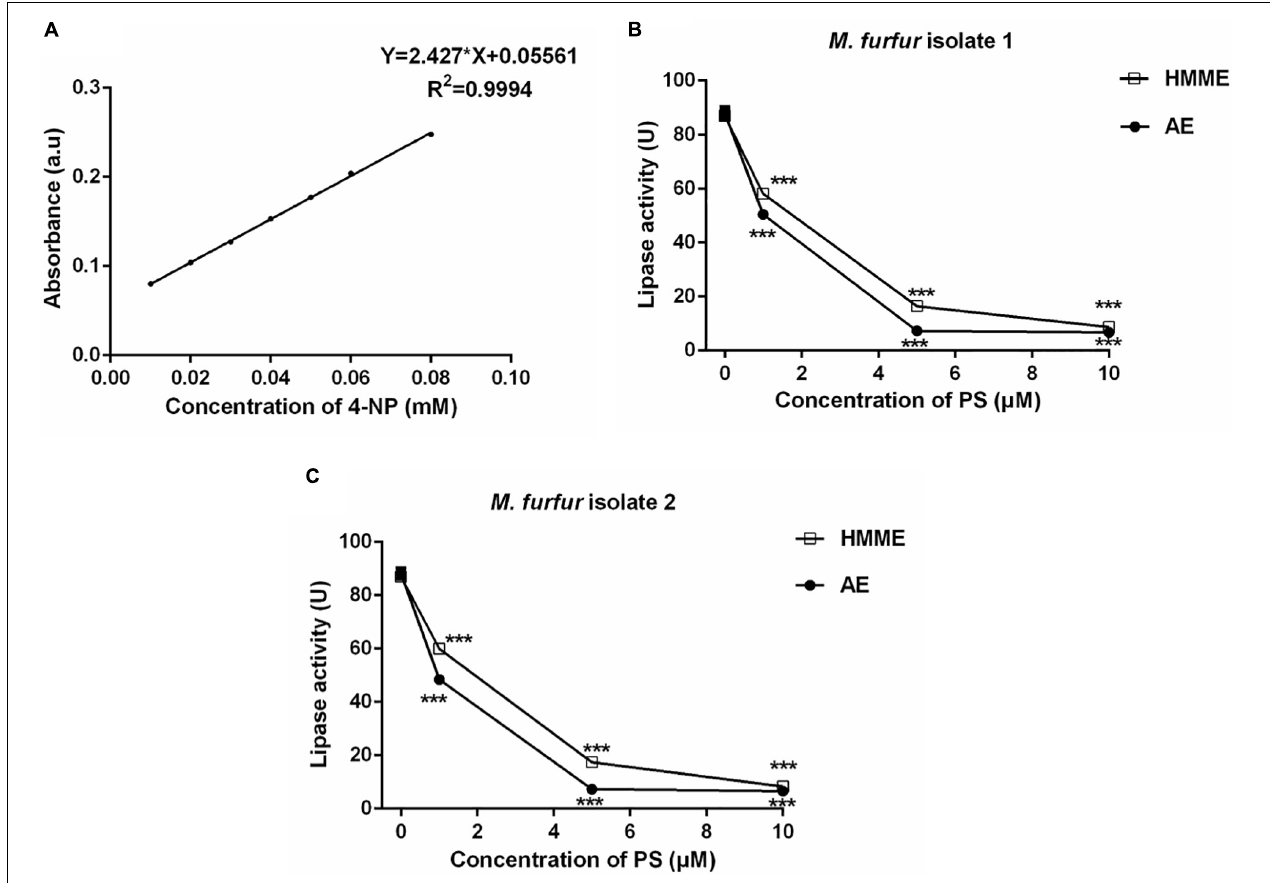
FIGURE 9 | Secreted lipase activity of M. furfur after HMME and AE-mediated aPDT. (A) Standard curve of 4-NP; (B) lipase activity of M. furfur isolate 1 treated with different concentrations of PSs and irradiated with 96 J cm − 2 of light; and (C) lipase activity of M. furfur isolate 2 treated with different concentrations of PSs and irradiated with 96 J cm − 2 of light. One unit of lipase activity is defined as the amount of 4-NP nmol h − 1 released from 4-NPP at 30 ◦ C. Each value refers to mean ± standard deviation (SD; n = 3; ns: no significance, *** P <